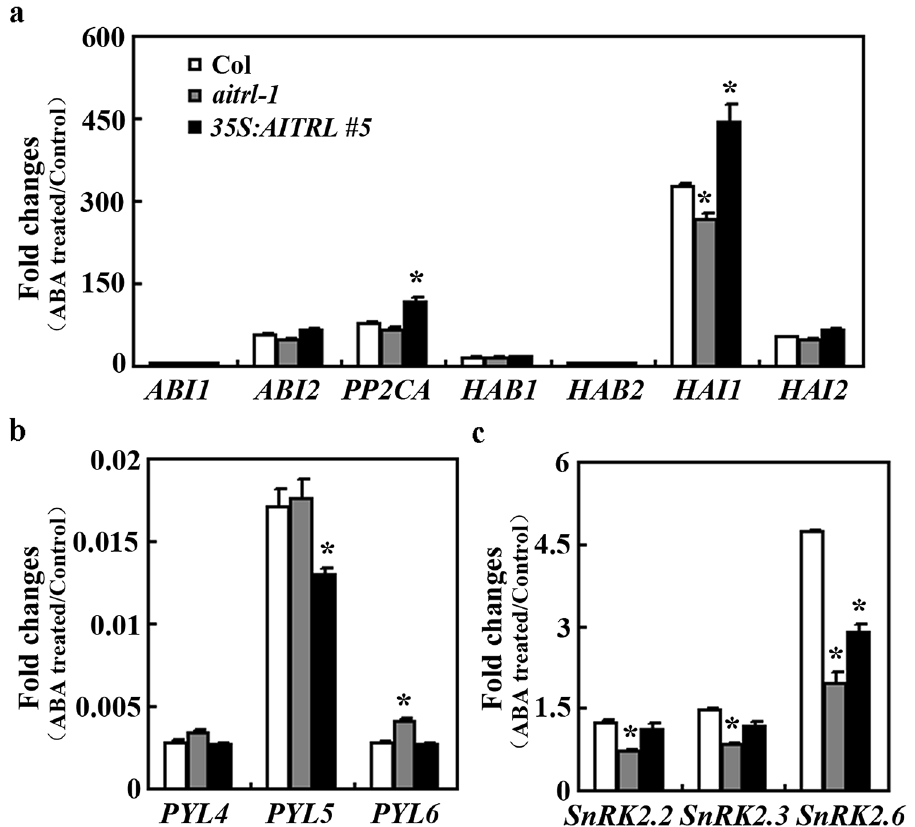
Figure 6. Expression of ABA signaling component genes in the Col wild type, the 35S:AITRL transgenic plants and the aitrl mutants. Expression of PP2C genes ( a ), PYL genes ( b ) and SnRK2 genes ( c ) in response to ABA in the Col wild type, the 35S:AITRL transgenic plants and the aitrl mutants. Twelve-day-old seedlings were treated with 50 µM ABA or solvent methanol as a control for 4 h. Total RNA was isolated and qRT-PCR was used to examine the expression of the ABA signaling component genes. The expression of ACT2 was used as an inner control. Fold changes were calculated by comparing the expression levels of the corresponding genes in ABA treated and the control seedlings. Data represent the mean ± SD of three replicates. *Significantly different from the wild type (p <